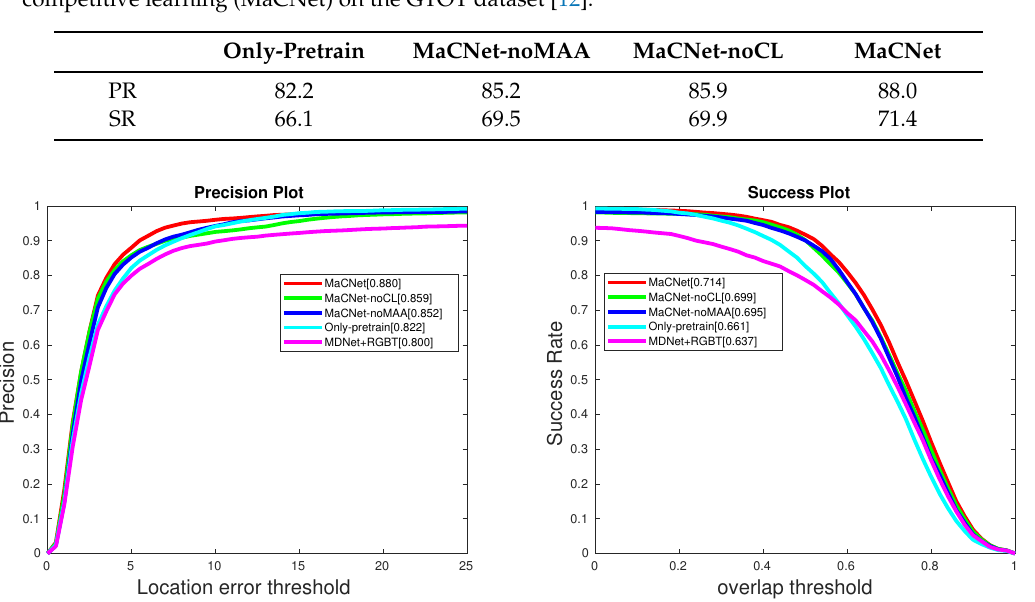
Figure 7. The comparison results of MaCNet and its variants on the GTOT dataset [12], where the representative PR and SR scores are presented in the